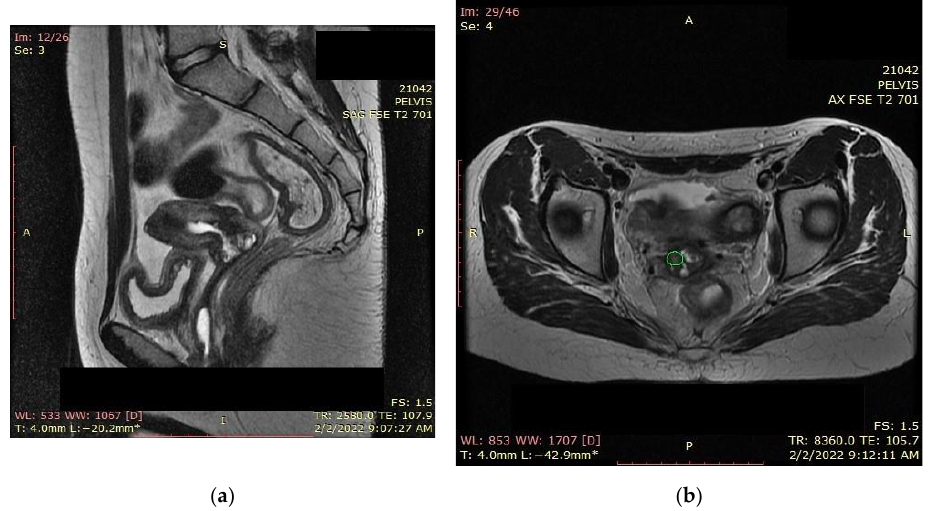
Figure 13. ( a ) MRI and ( b ) CT—significant favorable post-radiotherapy and chemotherapy response, with the persistence of a necrotic and ulcerative cervical area and a possible residual lesion on the right side of the cervix (the green highlighted area).